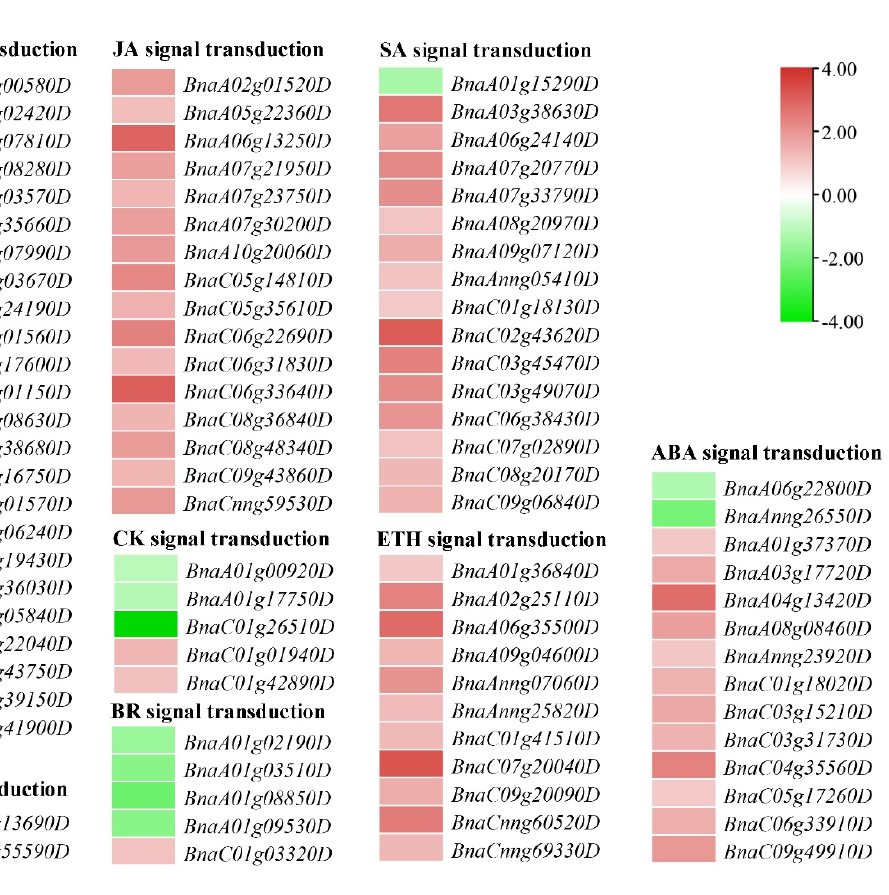
Figure 6. The DEGs (differentially expressed genes) for plant hormone signal transduction in the comparison of tall and dwarf plants ( Brassica napus ). Heatmaps indicate the log 2 (fold-change) of DEGs between tall and dwarf plants, in which the red to green shading indicates log 2 values ranging from high to low.